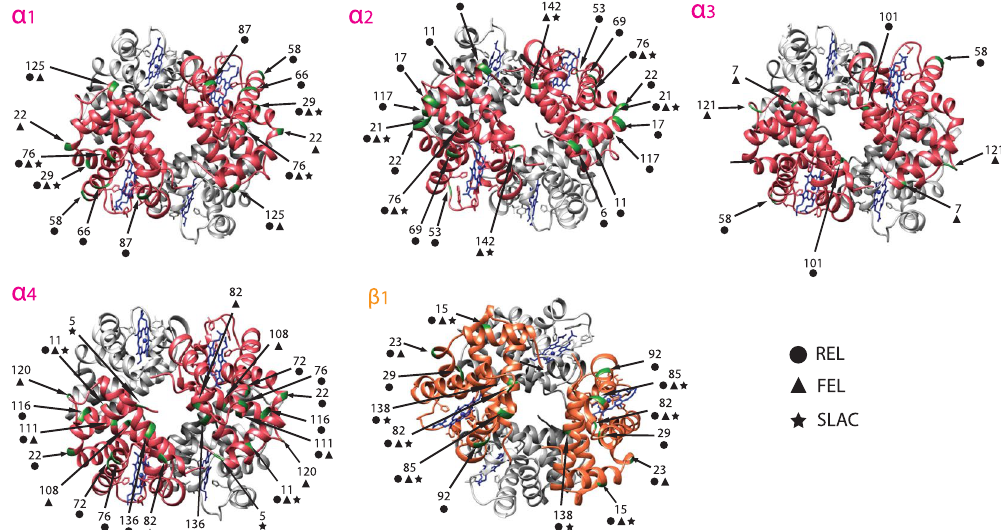
Figure 4. Sites under diversifying selection at the surface of hemoglobin tetramers. In silico models of the hemoglobin tetramers, based on sequences from Atlantic cod ( Gadus morhua ). α sequences are highlighted in pink, and β sequences in orange, with respective gene names shown. Three different tests (indicated by symbols according to the key) were used to test for diversifying selection; REL, FEL and SLAC, respectively. Arrows point to sites under diversifying selection, which are also highlighted in green.